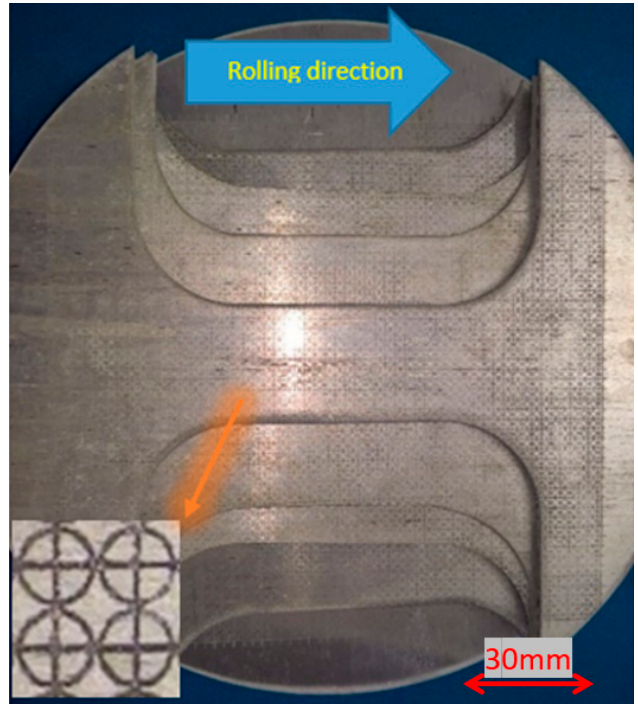
Figure 4. Blanks of FLD test pieces according to rolling direction; the blank width dimensions are 30, 70, 90, 120, and 185 mm.